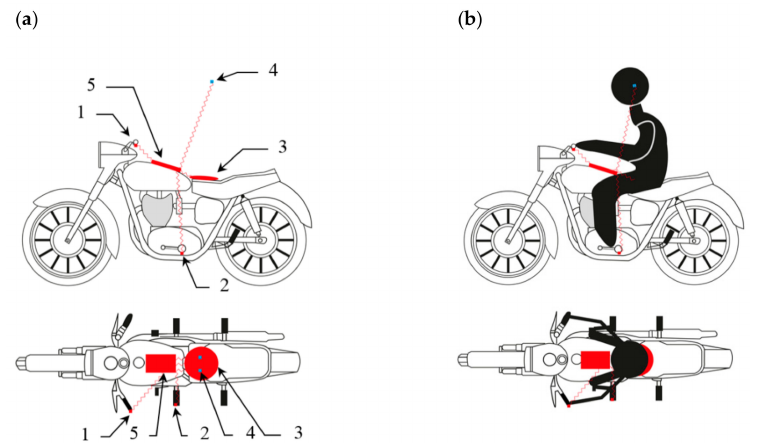
Figure 3. Diagram of the arrangement of the sensors in a system without ( a ) and with the motorcyclist ( b ), where [80]: 1–2—3-axis transducers, 3—measuring pad with a 3-axis transducer, 4—4’-binaural microphones, 5—recording